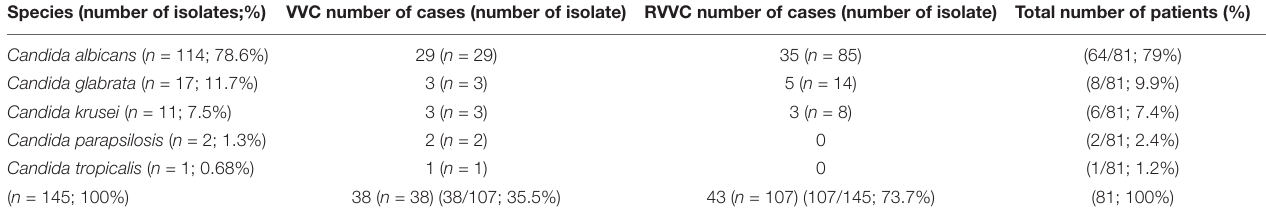
TABLE 1 | Isolate and patient numbers and Candida species distribution among patients with VVC and RVVC. Species (number of isolates;%) VVC number of cases (number of isolate) RVVC number of cases (number of isolate) Total number of patients (%) Candida albicans ( n = 114;